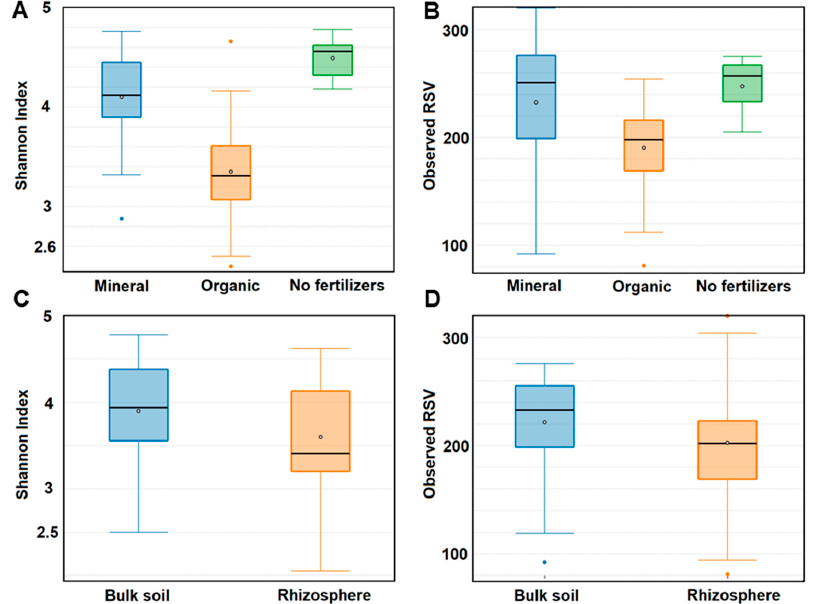
Figure 6. Alpha-diversity of bulk soil and rhizosphere mycobiomes. ( A , B ) Numbers of ribosomal sequence variants (RSV) and Shannon indexes when comparing all samples corresponding to mineral and organic fertilizer system ( N = 36). ( C , D ) Numbers of RSV and Shannon indexes when comparing all rhizosphere and bulk soil samples ( N = 36).